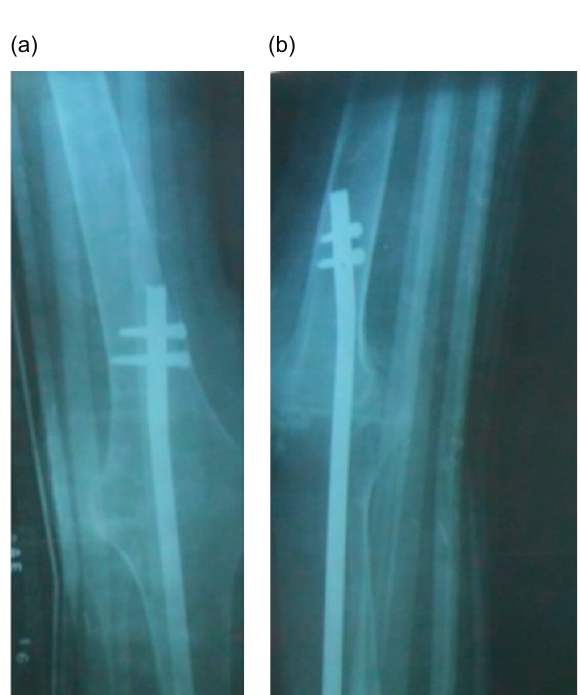
Figure 4. Postoperative anteroposterior (a) and lateral (b) radio- graphs of knee fusion with SIGN nail construct.